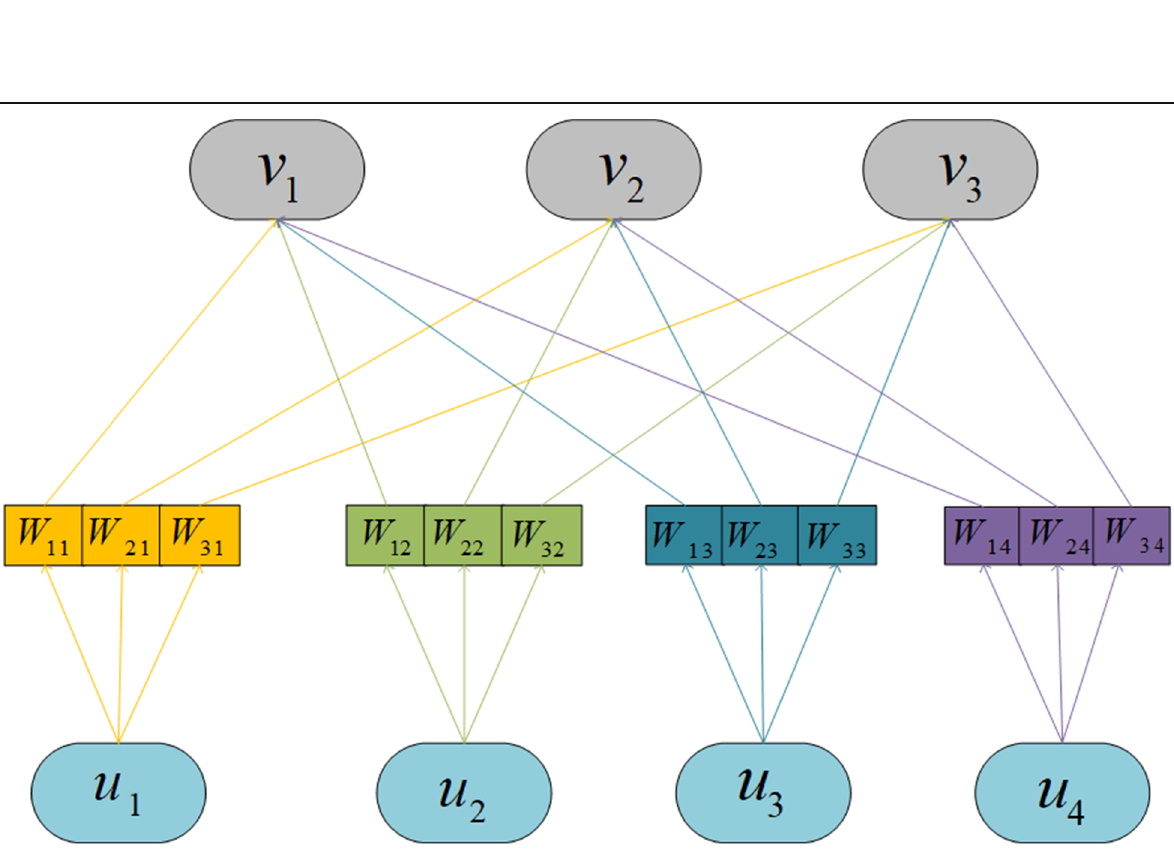
Fig. 4 Full contact